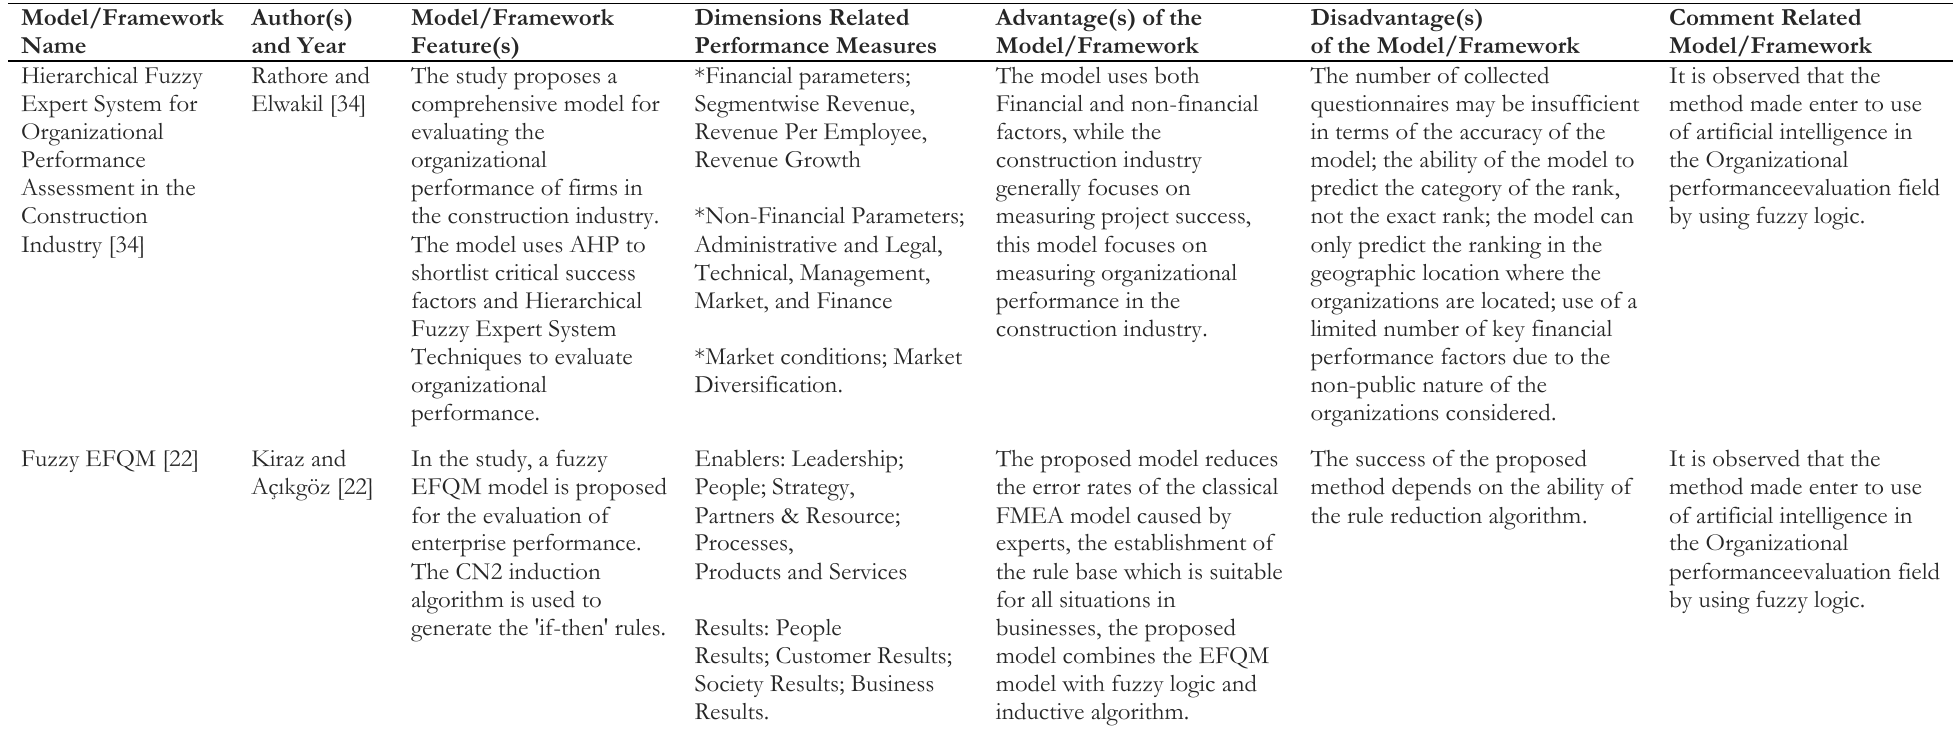
Table 10. Organizational performance measurement models developed in Industry 4.0